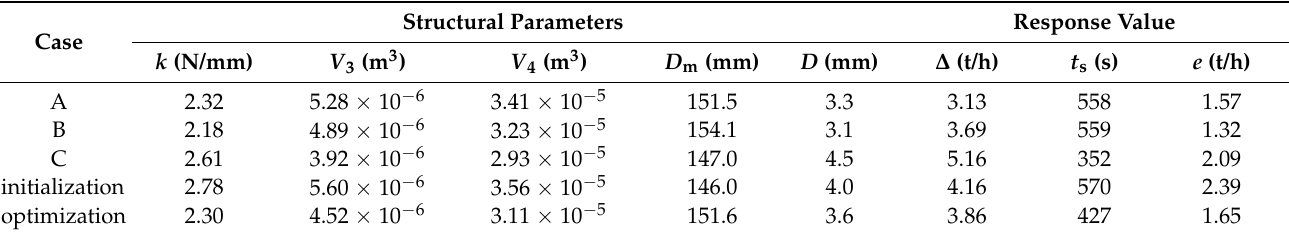
Table 4. Improved NSGA-II solution results.